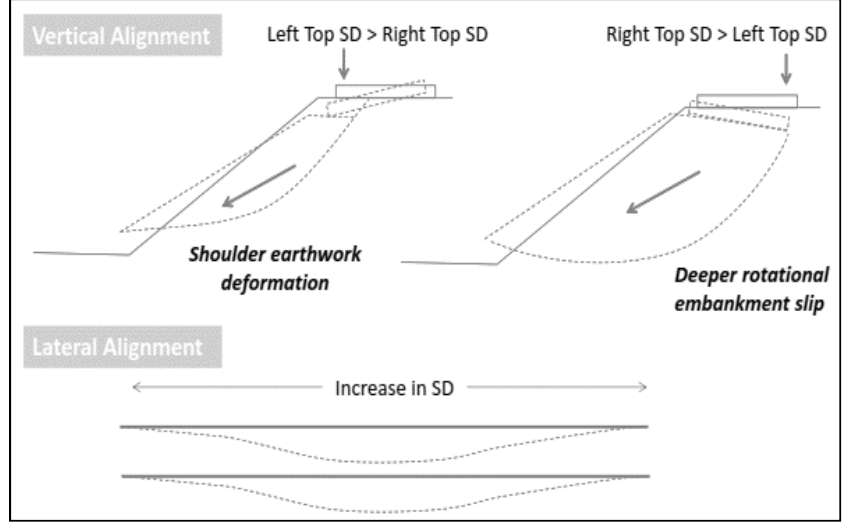
Figure 4 . Effect of typical rotational slip on track geometry—adapted from [25]